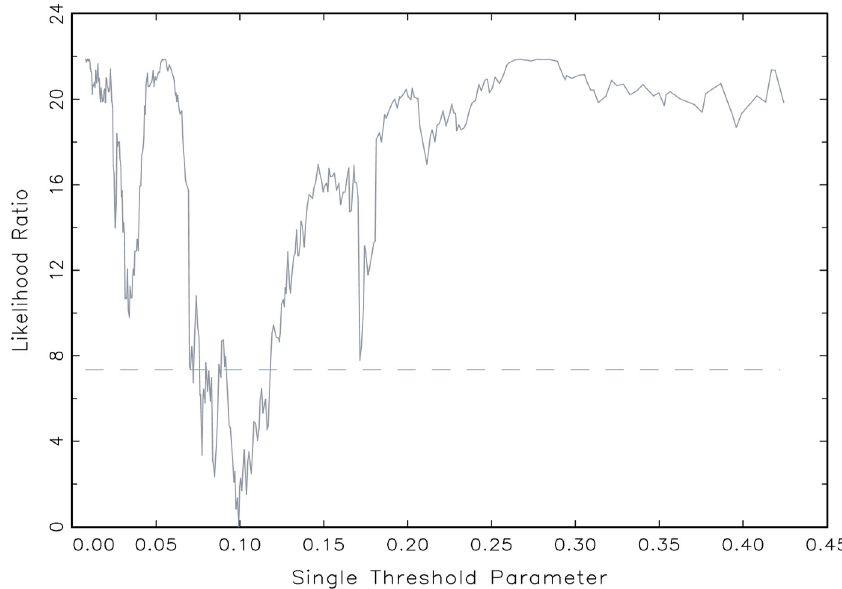
Figure 1. Confidence interval for the single-threshold model. Table 4. Estimated results of regression coe ffi cient for the cash holding ratio.